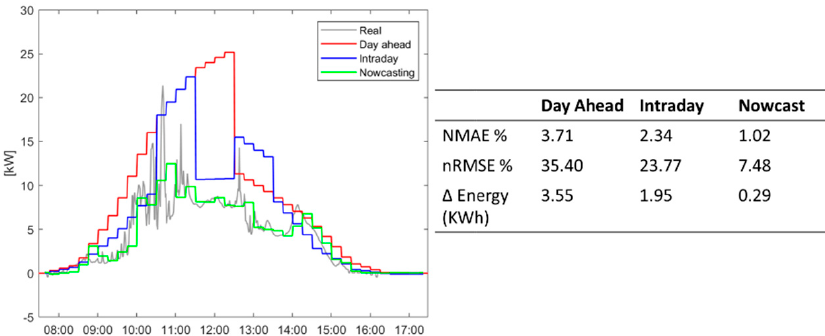
Figure 12. PV forecasts and real profiles—day 3.